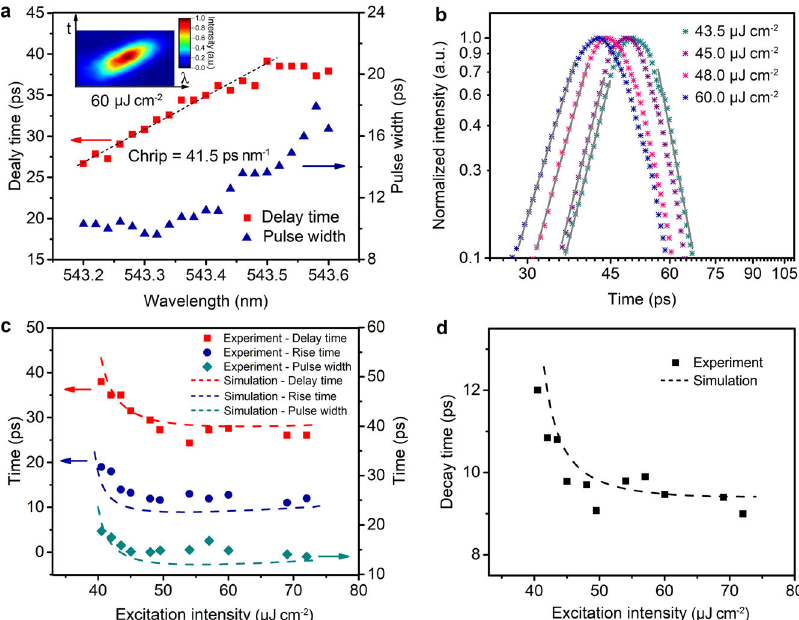
Fig. 4 Gain-switching characteristics of output pulses in CsPbBr 3 microwires. a Delay time and pulse width of optical pulse at 60 μ J cm − 2 with respect to wavelength. The error bars that represent the standard deviation from the mean are too small to be visible. The inset shows the streak camera image at 60 μ J cm − 2 . b Normalized log-log plots of gain-switched pulse waveforms in Fig. 3. An exponential model (gray solid lines) fi ts well to the experimental data. The excitation energy-dependent delay time (red squares), rise time (circles), pulse width (diamonds) ( c ) and decay time (black squares) ( d ) of gain- switched pulses. The error bars here are too small to be visible. Dashed curves show the simulation